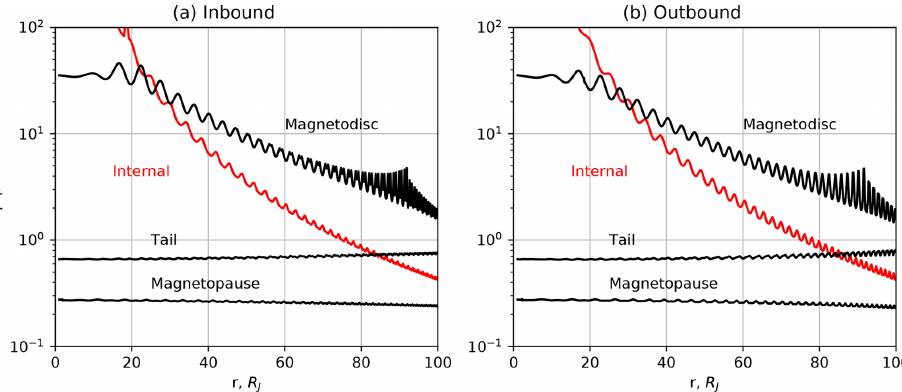
Figure 3. Magnitude of the model magnetic fields for the Juno perijove 1 inbound (a) and outbound (b) passes, due to the internal planetary field (JRM09, in red), and the various model magnetospheric currents as marked (magnetopause, tail, and magnetodisc, in black).